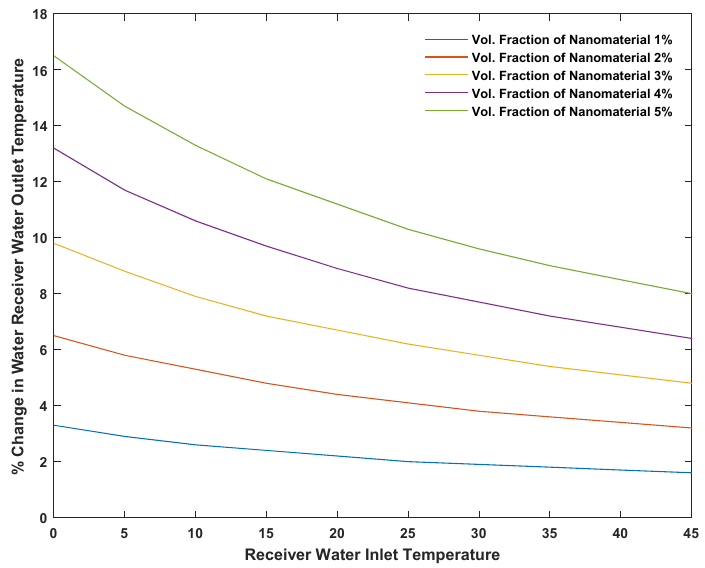
Fig. 8. Effect of Volume fraction on receiver water outlet temperature